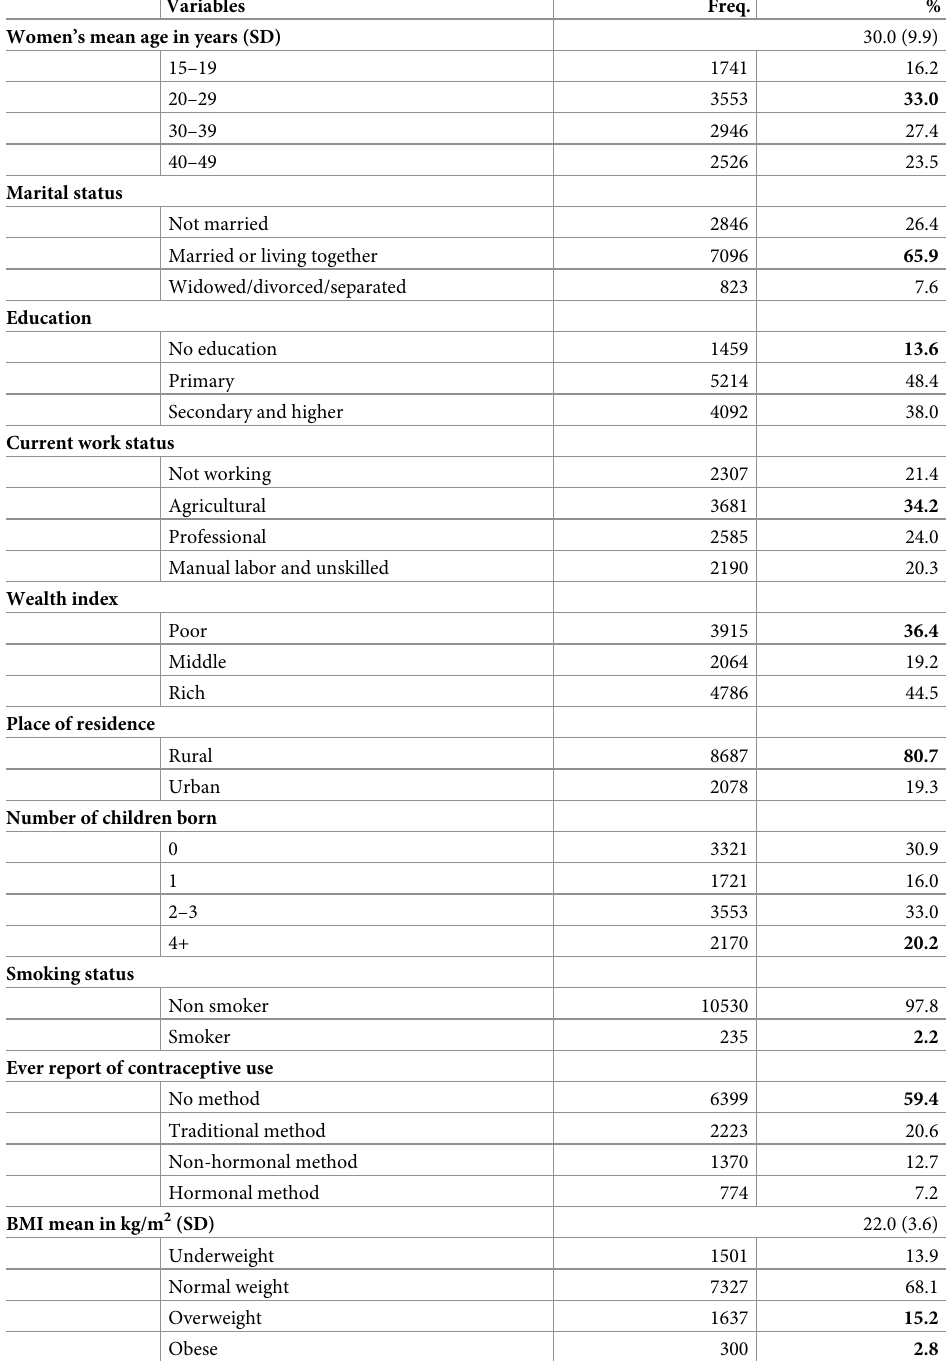
Table 1. Socio-demographic and behaviors characteristics of the weighted samples of women aged 15–49 years old in Cambodia, 2014 (n = 10,765, weighted count).